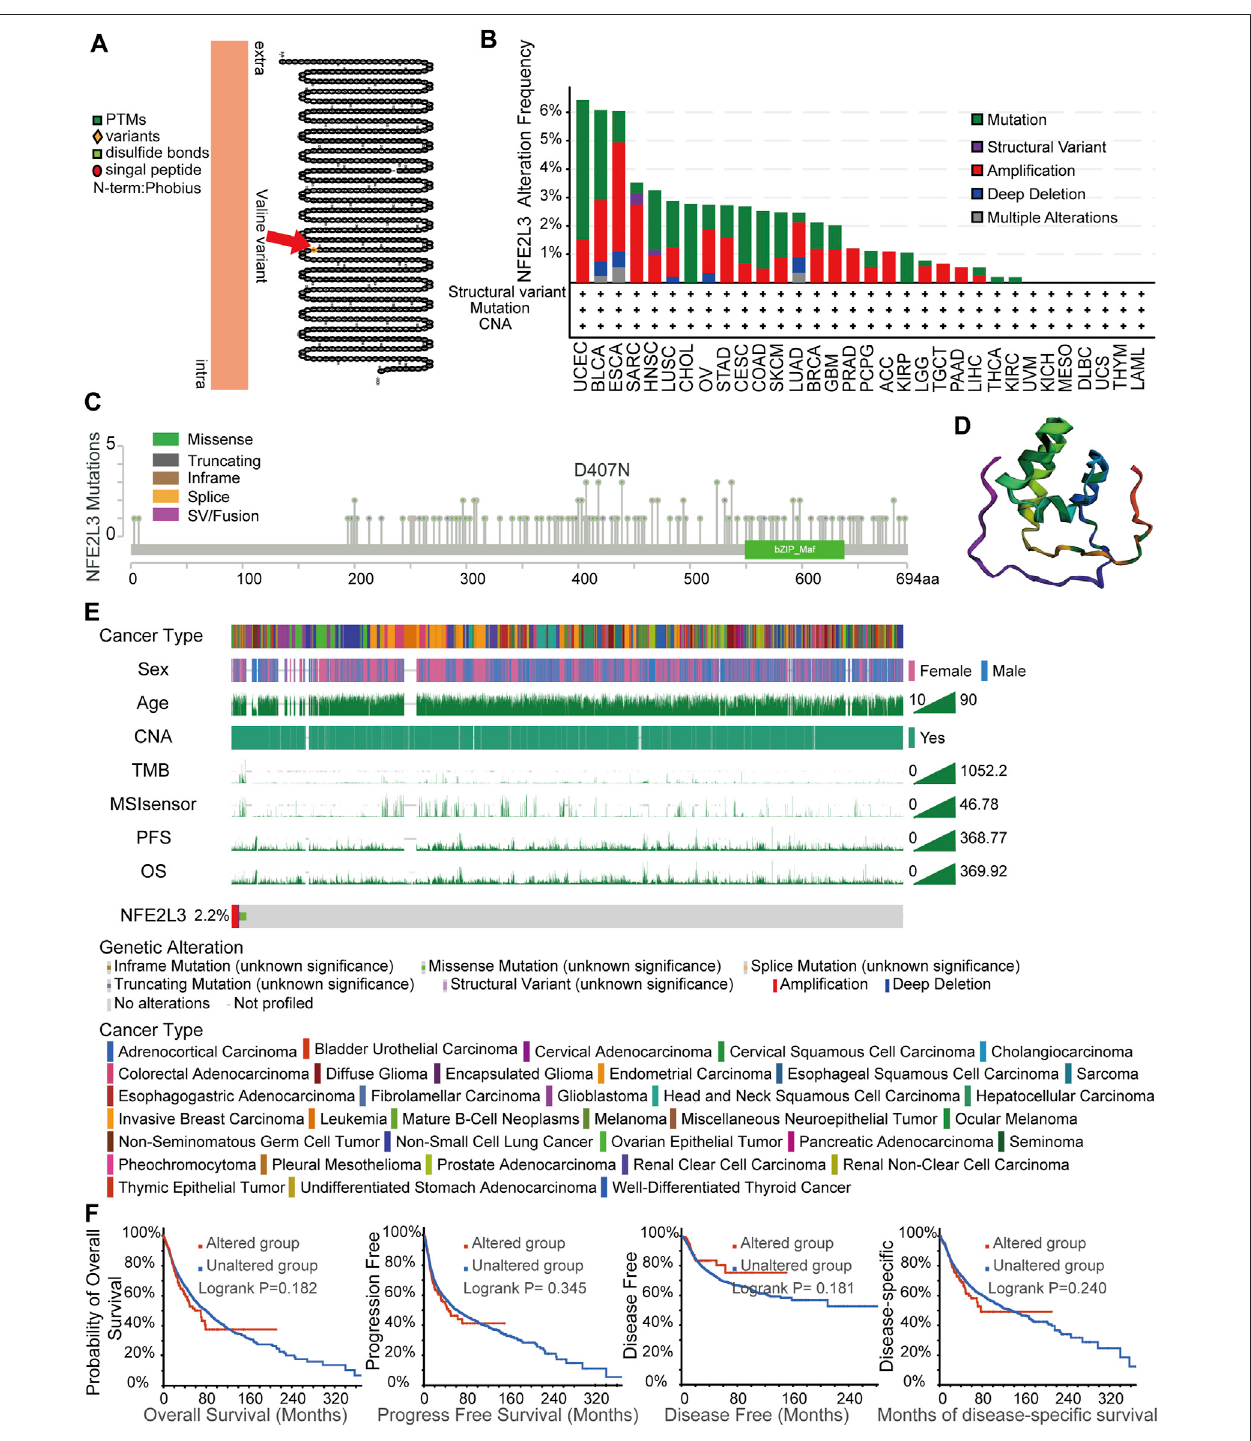
FIGURE 6 | NFE2L3 variant and the characteristics of NFE2L3 mutations in TCGA cohort. (A) A natural missense variant of Valine441 in transmembrane protein topologyofNFE2L3. (B) Genetic alteration frequencies ofNFE2L3inTCGA pan-cancer cohorts. (C) Typeand site ofmutationsofNFE2L3. (D) Variant distributionof3D proteinstructureofNFE2L3. (E) Thecorrelation ofNFE2L3 status andclinical characteristics inTCGA pan-cancercohort. (F) Thecorrelation betweenNFE2L3mutation status and prognosis (OS, PFS, DFS, and DSS) of cancer.